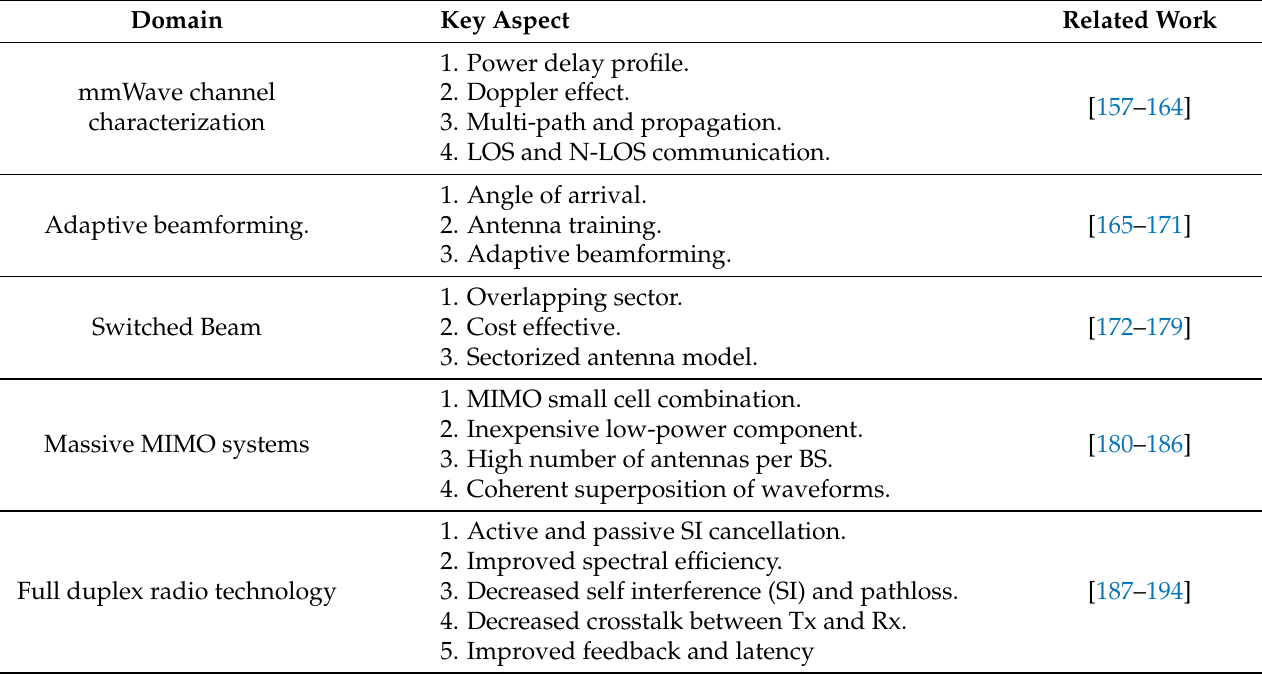
Table 5. Summary of the related work on the physical layer in 5G wireless